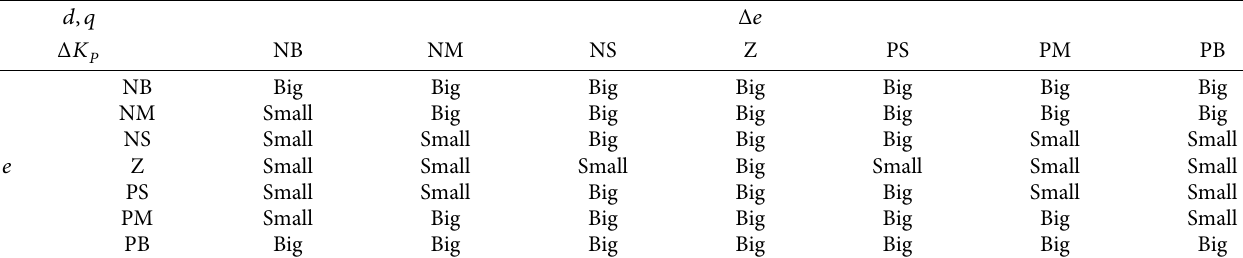
dq -axis. P output for